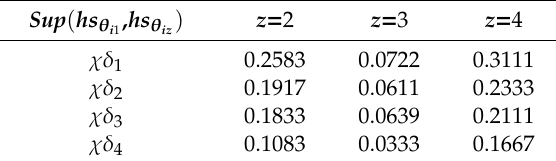
Table 2. Support degree of hs θ